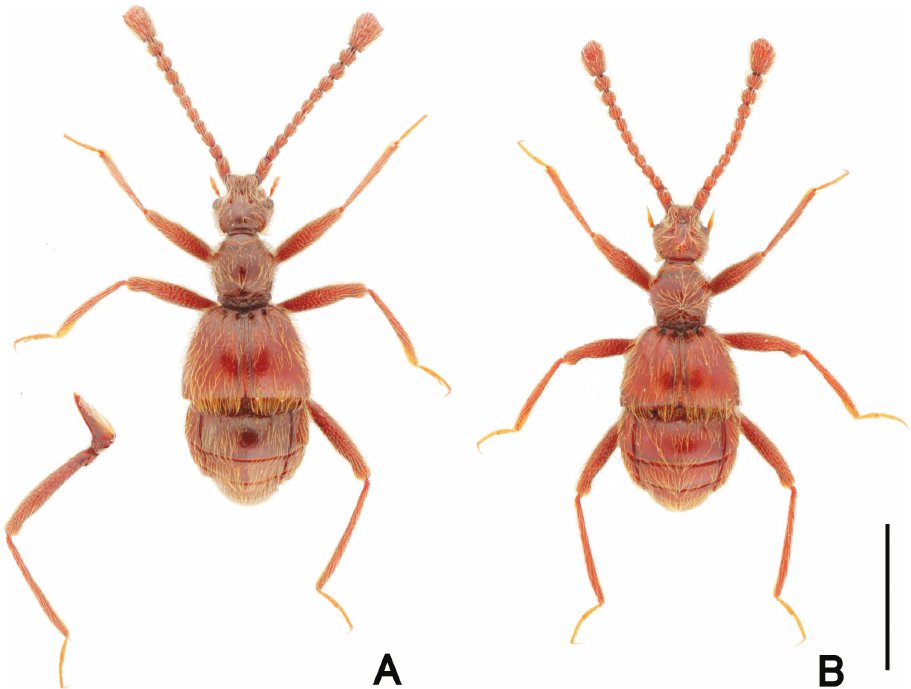
Figure 1. Dorsal habitus of Pseudophanias yaimensis A male B female. Scale bar: 1.0